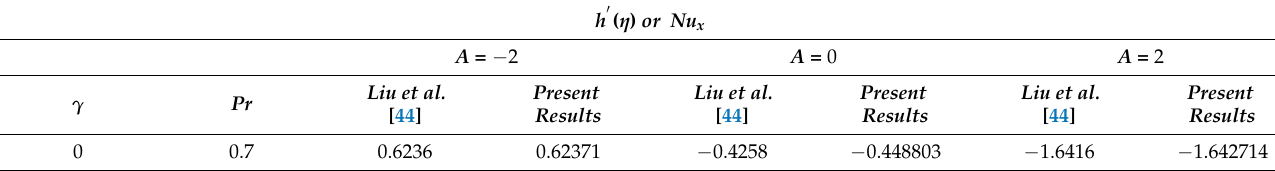
Table 2. Comparison of Nusselt number ( Nu x ) with [44], when Prandtl number Pr = 0.7 is and stretching ratio γ and temperature exponent A are